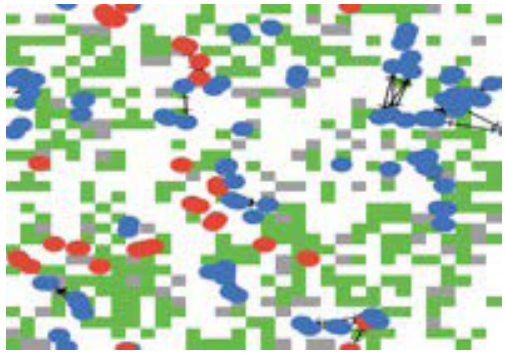
Figure 1. (a) None of the agents